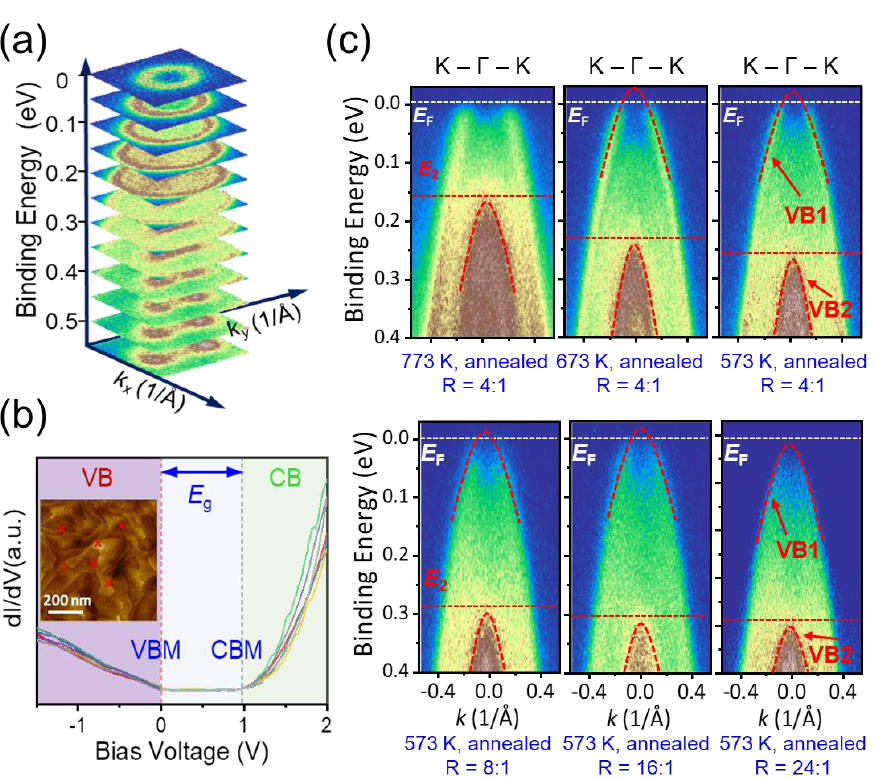
Figure 6. ( a ) ARPES maps of constant energy contours at different binding energies for the Mg 3 Sb 2 film grown and in-situ annealed at T sub = 773 K. ( b ) STS spectra of the Mg 3 Sb 2 film in ( a ), which are measured from different regions (see the marks in the insert). The VBM, CBM and E g indicate the valence band maximum, conduction band minimum and band gap, respectively. ( c ) ARPES spectra along the K- Γ -K direction of Mg 3 Sb 2 films grown under different T sub and Mg/Sb ratios R. The E F , VB1 and VB2 represent the Fermi energy, the topmost valence band, and the second valence band, respectively. Lowering the T sub and increasing the R both shift the E F towards the conduction